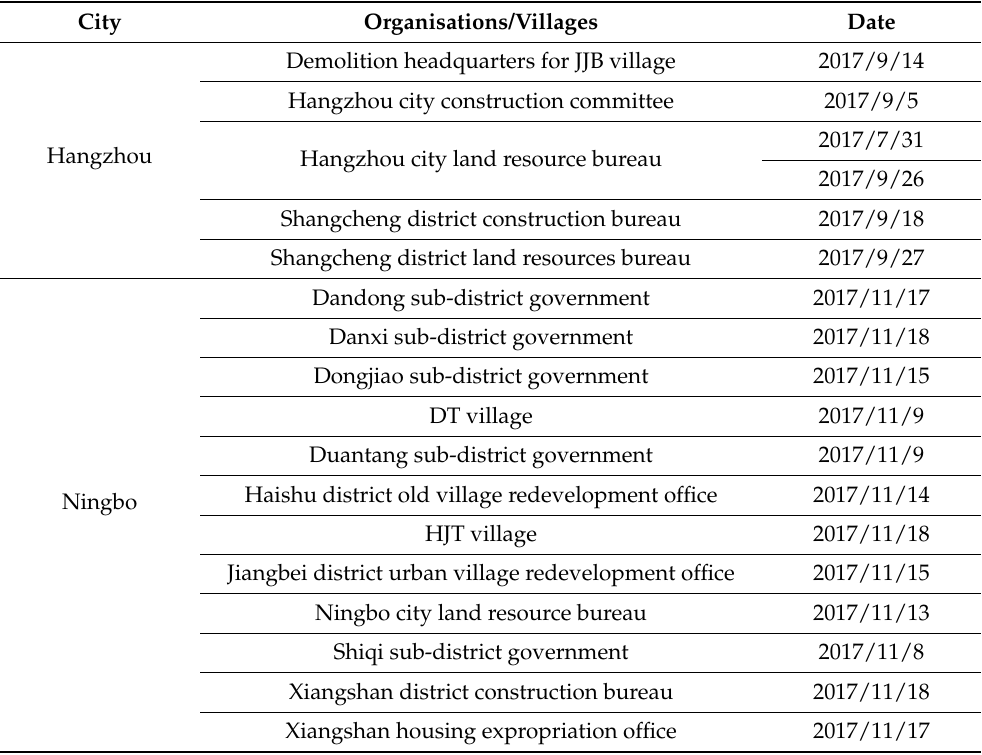
Table A1. A list of key